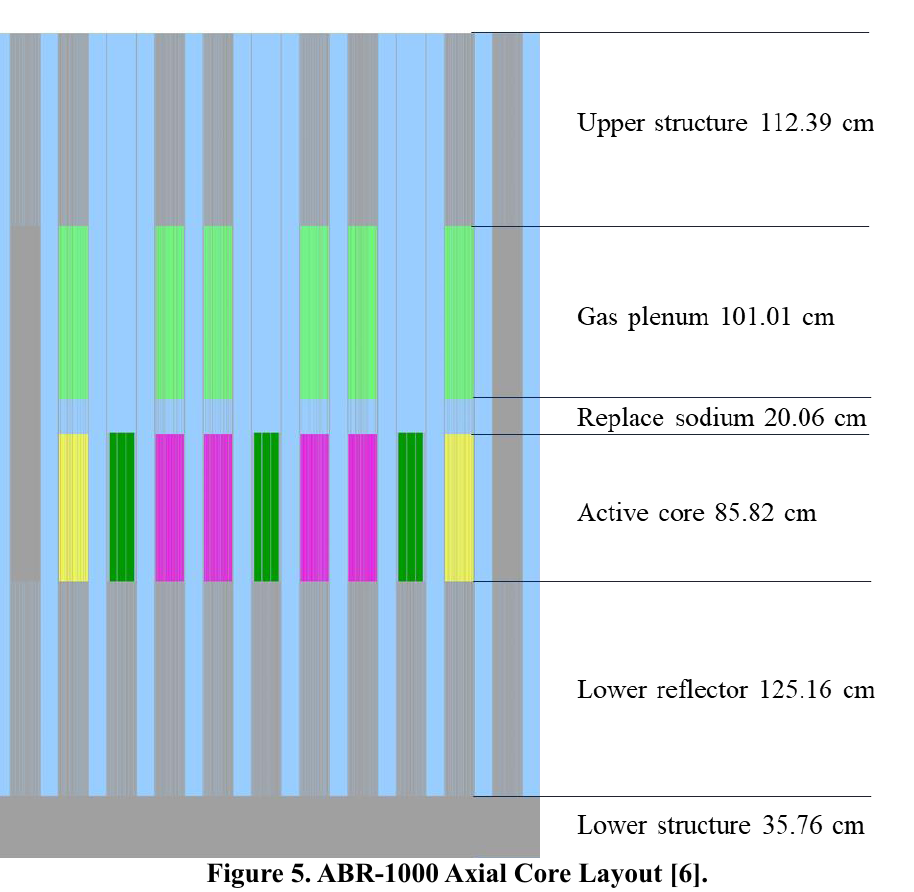
Figure 5. ABR-1000 Axial Core Layout [6].